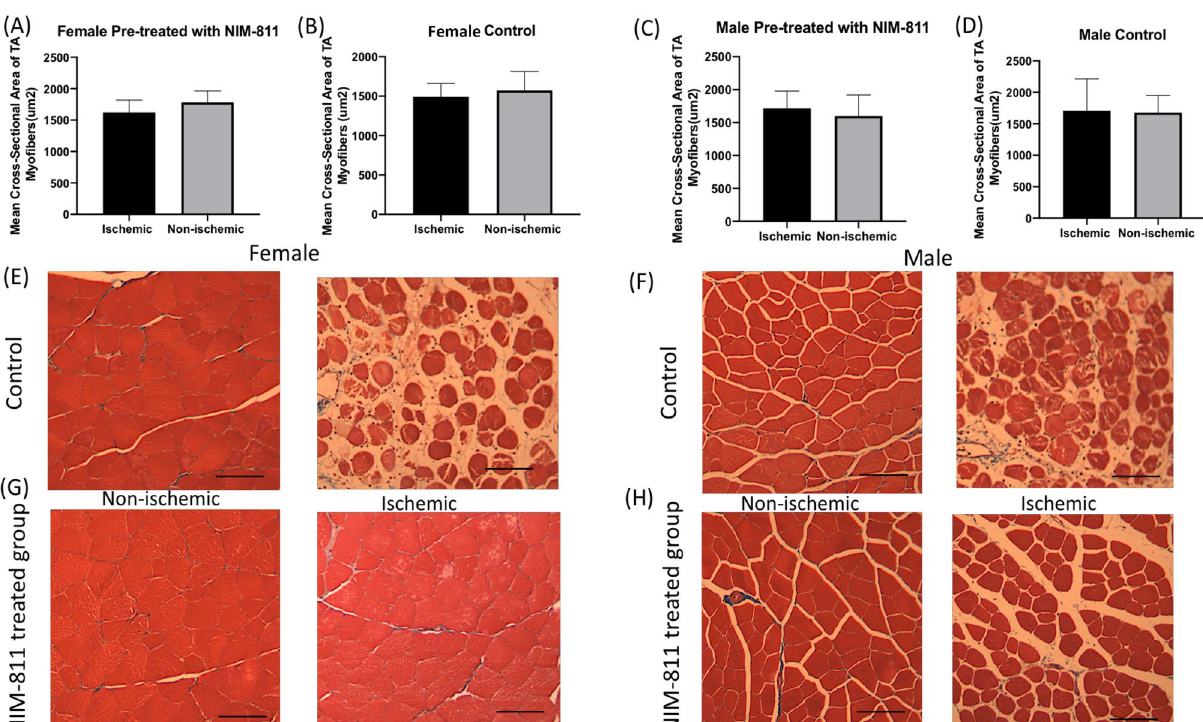
Figure 4. Histology of muscle tissue. ( A – D ) Morphometric analysis of muscle fiber cross-sectional area of the TA muscles intact fibers in female and male mice does not differ significantly between the ischemic limbs of vehicle (control) and NIM-811 treated mice. ( E – H ) Hematoxylin and eosin (H&E)/ trichome sections of TA muscle fibers from the ischemic limbs of vehicle-treated female and male mice show some shrinkage, necrosis, and irregular morphology compared to non-ischemic limb from the same group. The muscle fiber morphology was more regular, and staining was more uniform from the ischemic limbs of NIM-811 treated mice, most of the muscle cell was still located in the muscle membrane, and degeneration less frequent compared to the non- ischemic limb from the same group. Scale bar = 100